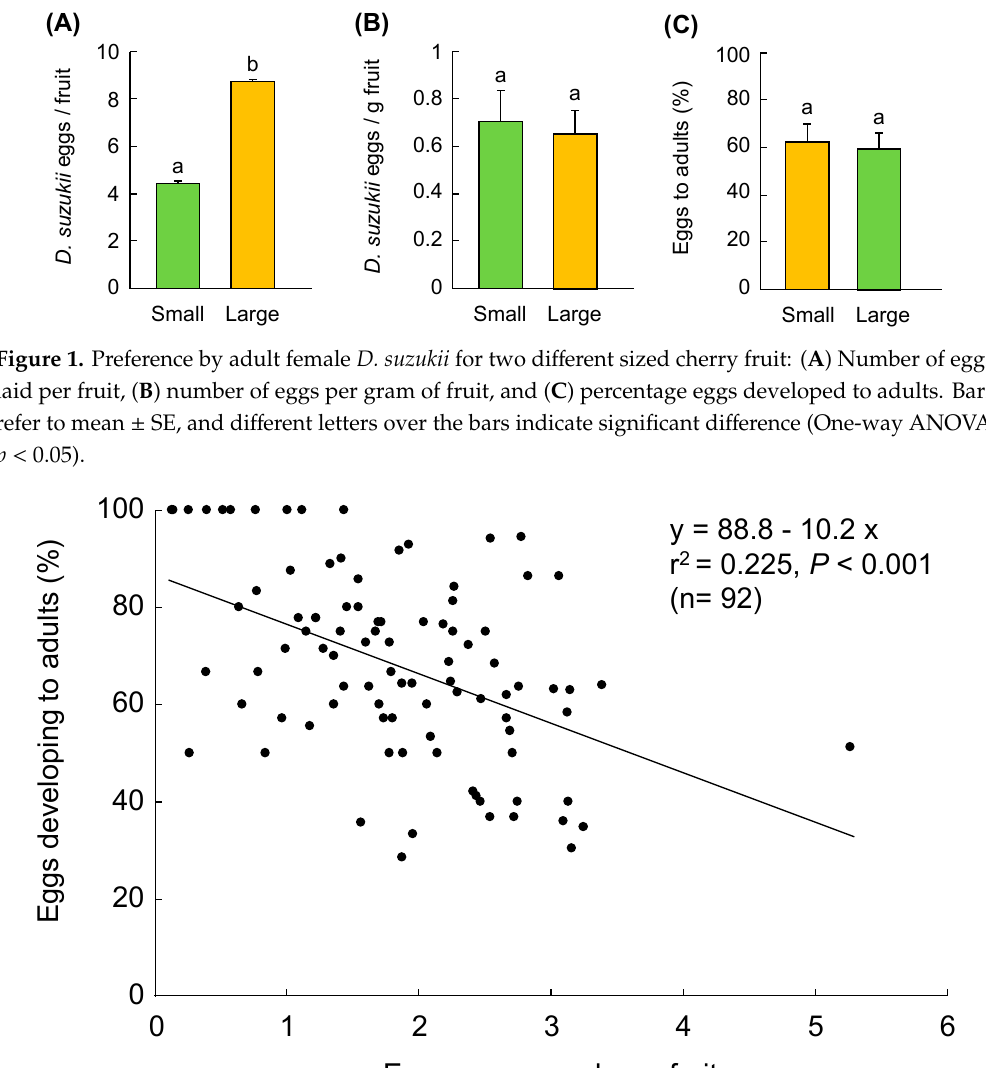
Figure 2. Percentage of D. suzukii eggs successfully developed to adult flies decreased with increasing egg density per gram of fruit.